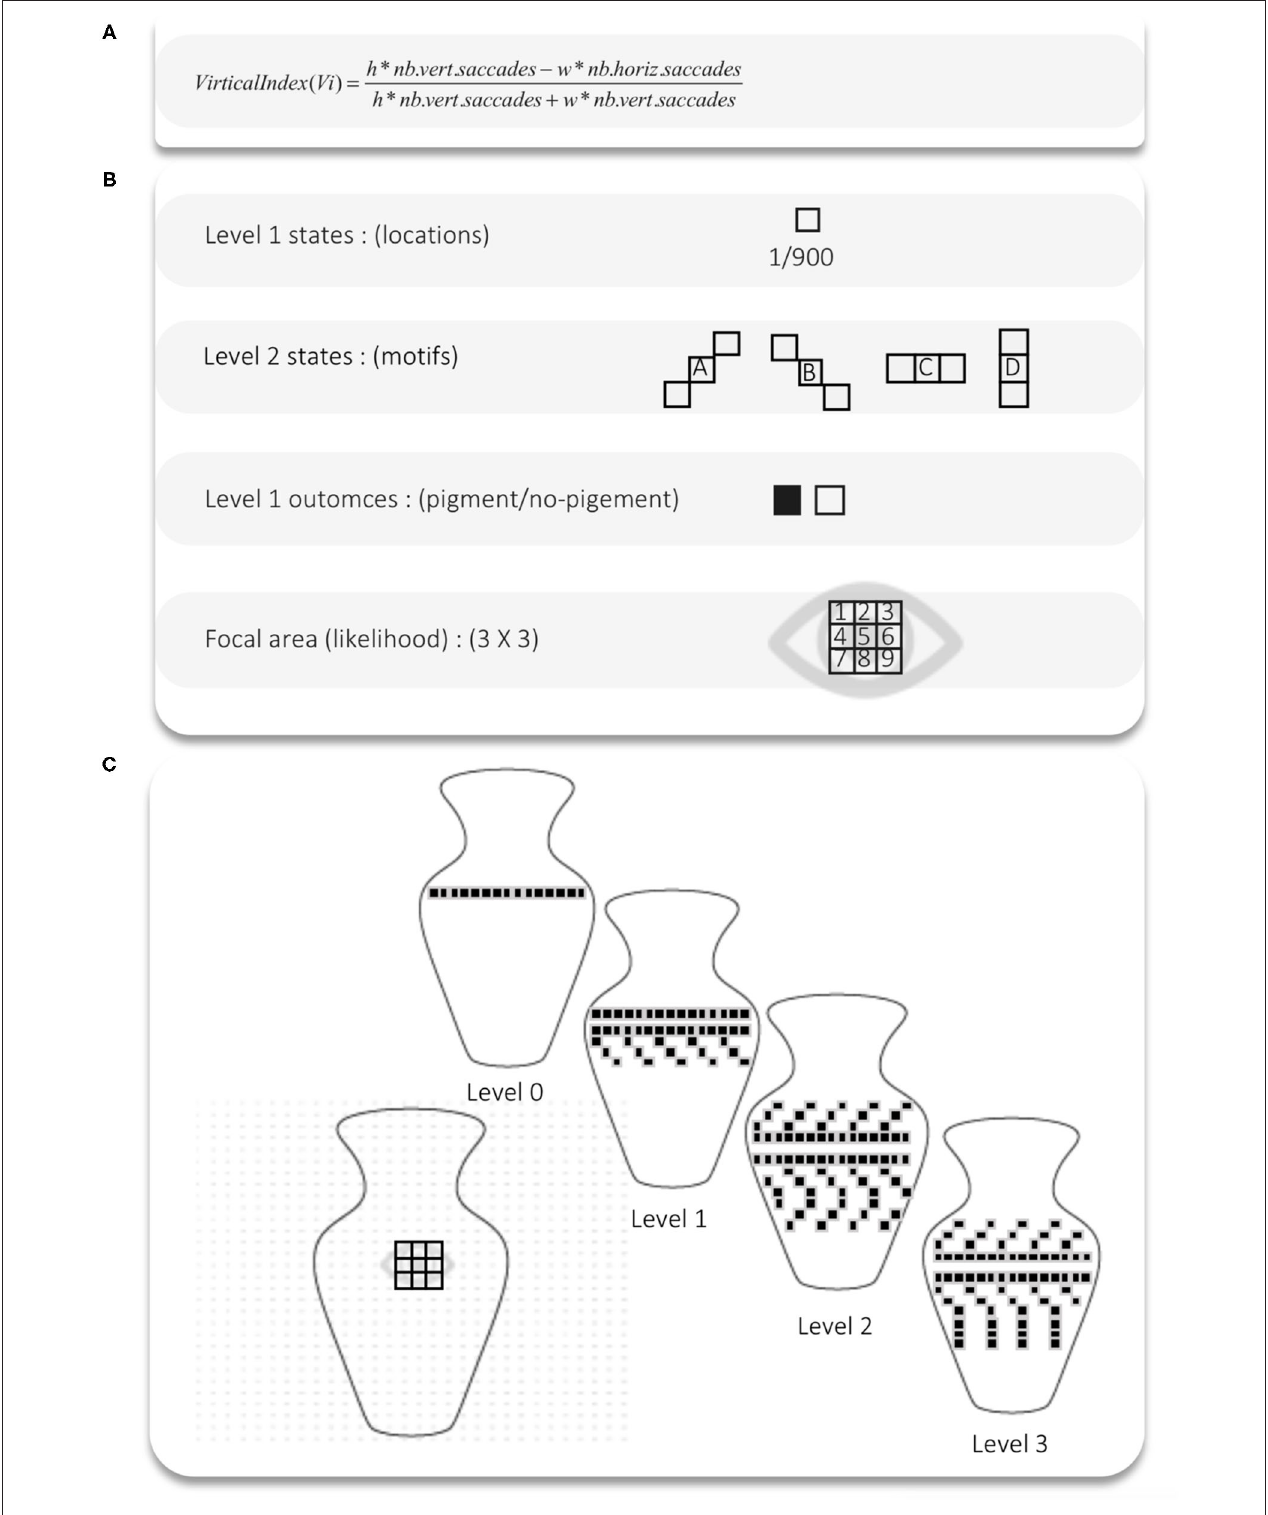
FIGURE 2 | (A) Vi is a measure of visual saccades relative to the size of the visual area gazed upon. This area increases with decoration complexity. (B) States and outcomes for the generative model. At level 1, the outcomes are the absence or presence of a pigment. The states are the locations (1/900) of which